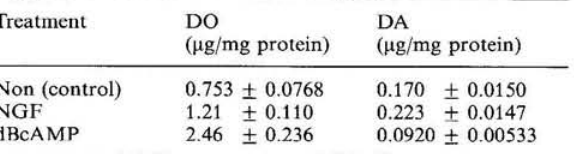
Table 1. Effect of NGF and dBcAMP on DO and DA contents in PC12h pheochromocytoma cells. Treatment DO DA (W5/ m S protein)